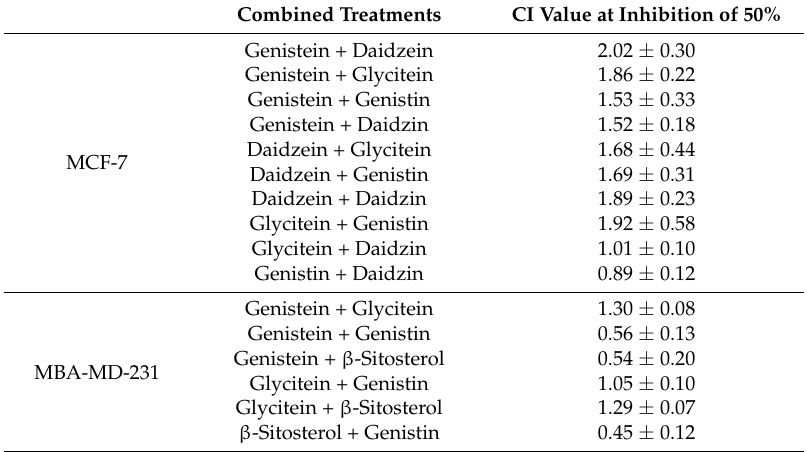
Table 1. CI 50 values a of bioactive anticarcinogens by single or two-way combination treatment in MCF-7 and MDA-MB-231 human cancer cells.